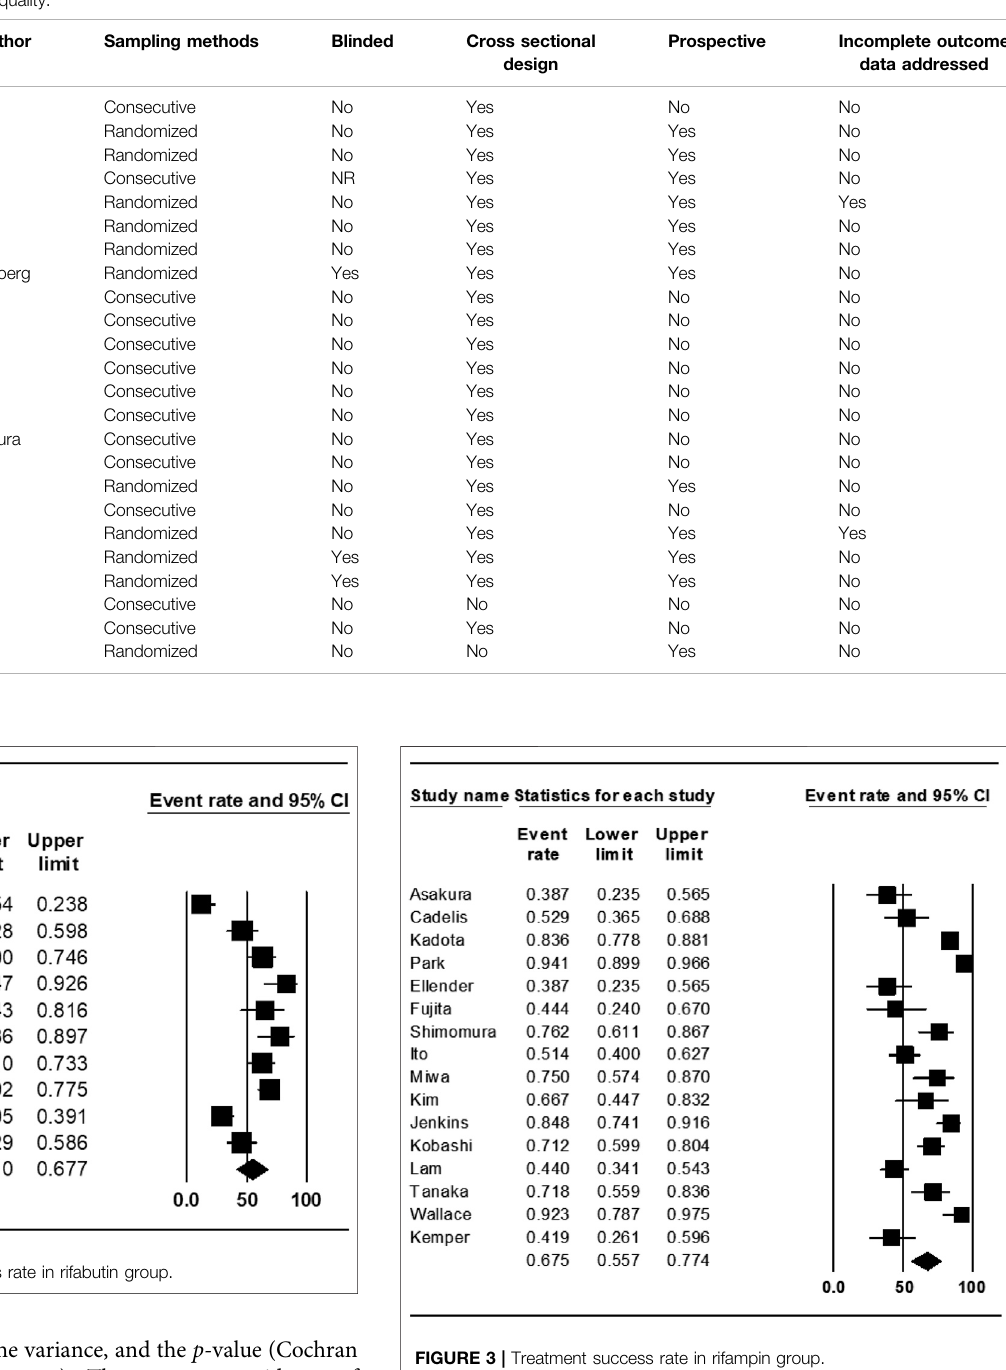
FIGURE 3 | Treatment success rate in rifampin